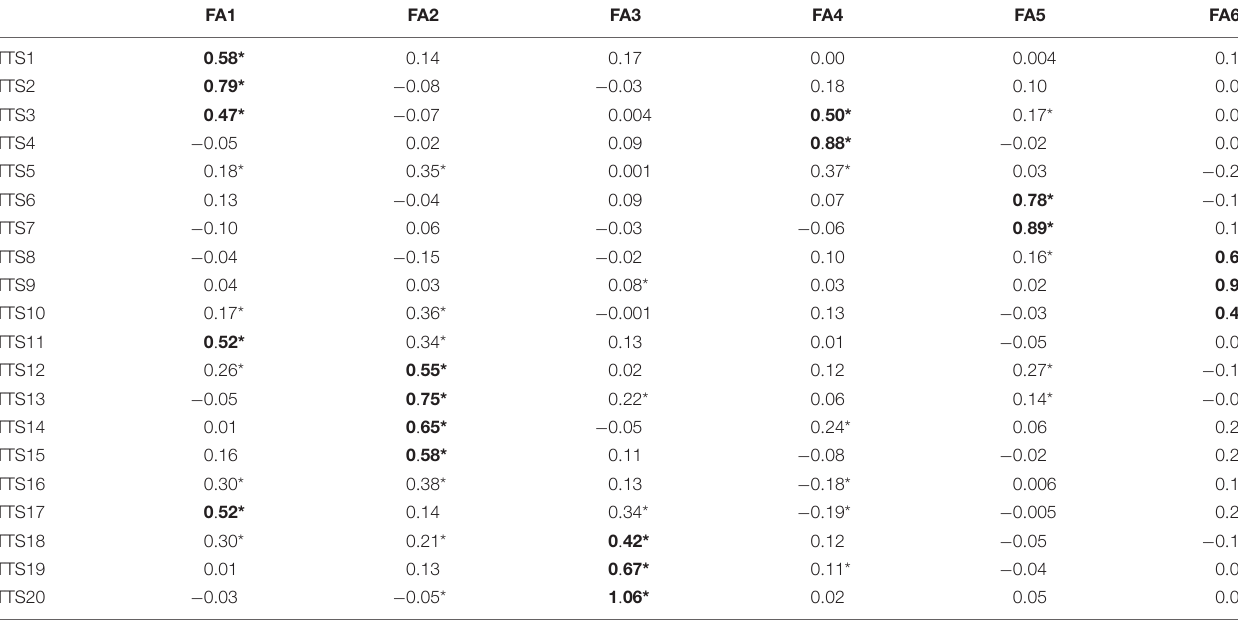
Factor loadings are emboldened if their magnitude is over 0.4. Items below a 0.4 loading are considered for deletion. Items TTS10, TTS11, and TTS17 are subject to further examination for cross-loadings. *Significant at the 5%